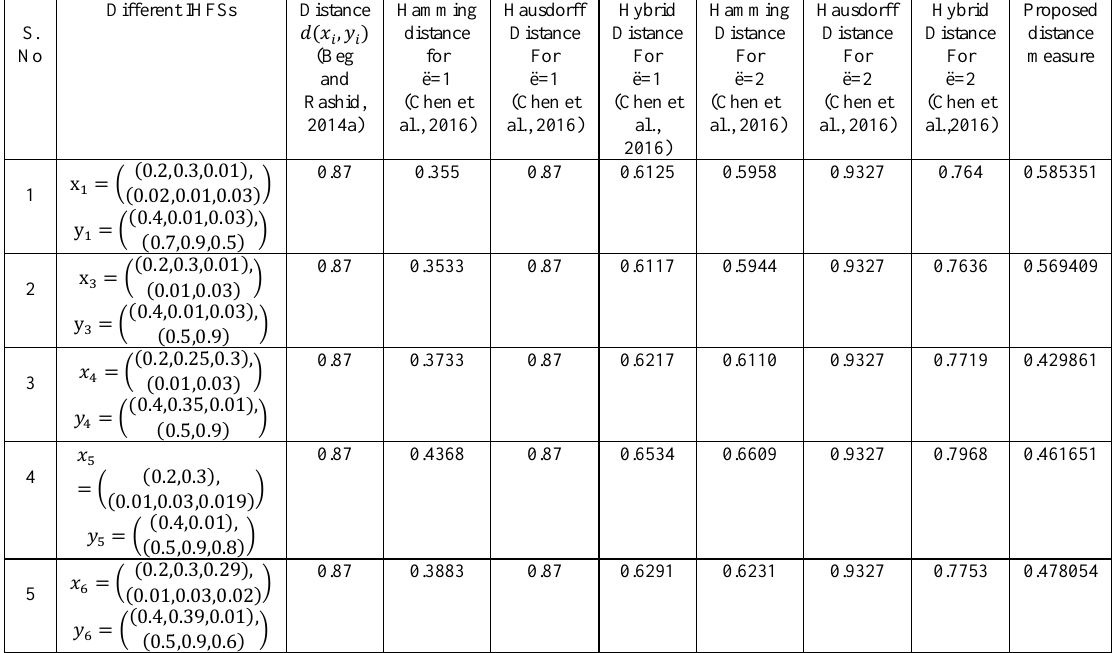
Table 1. Comparison of Distance degrees for different IHFSs using different distance measures S.